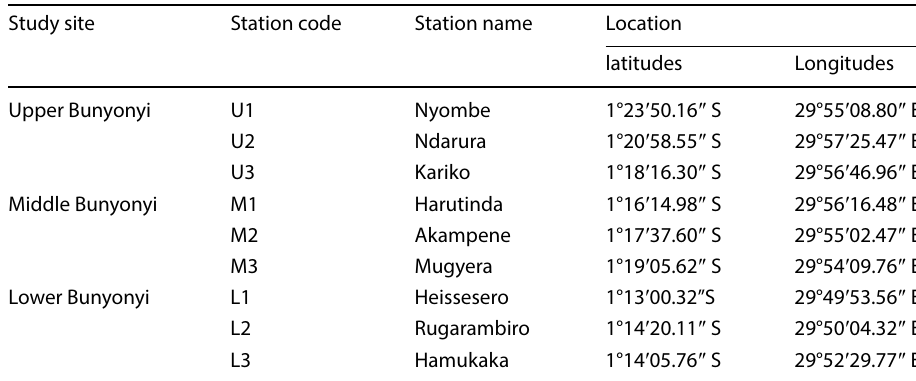
Table 1 Sampling site location for E. coli and Enterococci